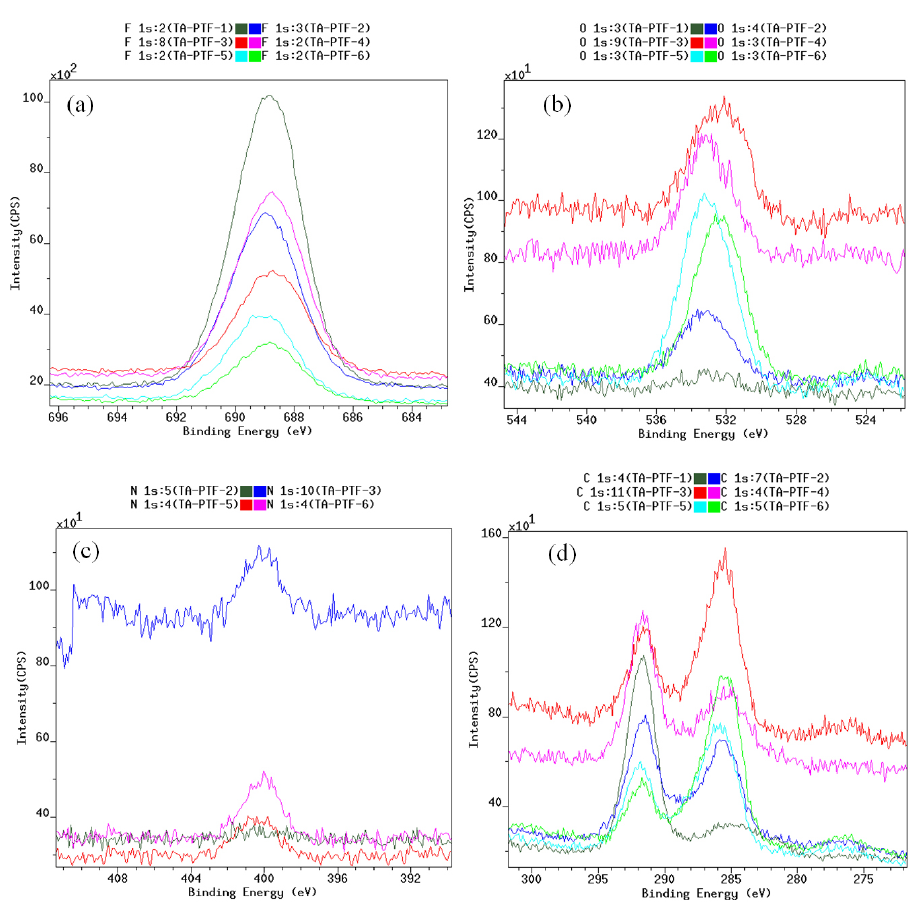
Figure 2 : XPS spectra of untreated and plasma-treated PTFE